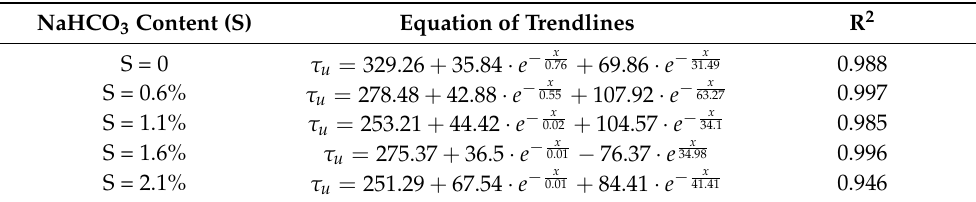
Table 6. Equation of trendlines of shear strength versus the number of FTCs at a confining pressure of 300